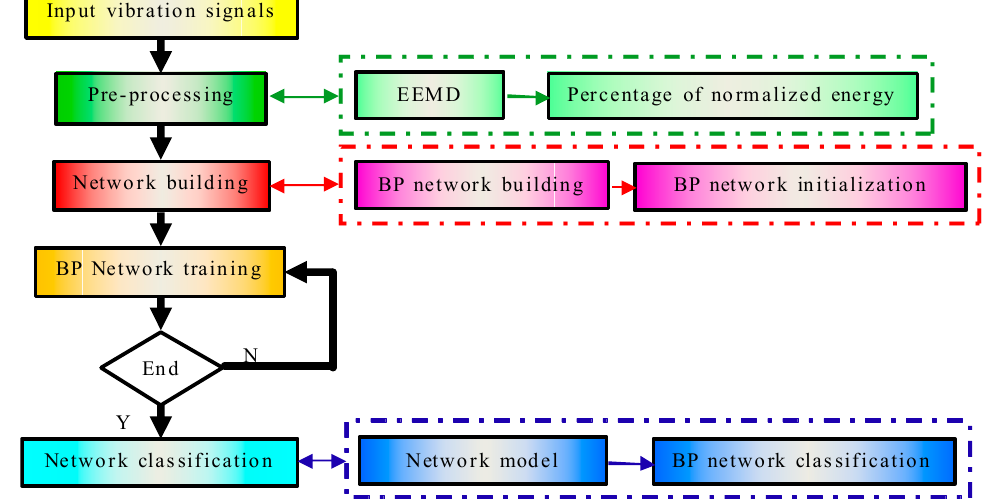
Figure 3. Flowchart combining EEMD and BP neural network.